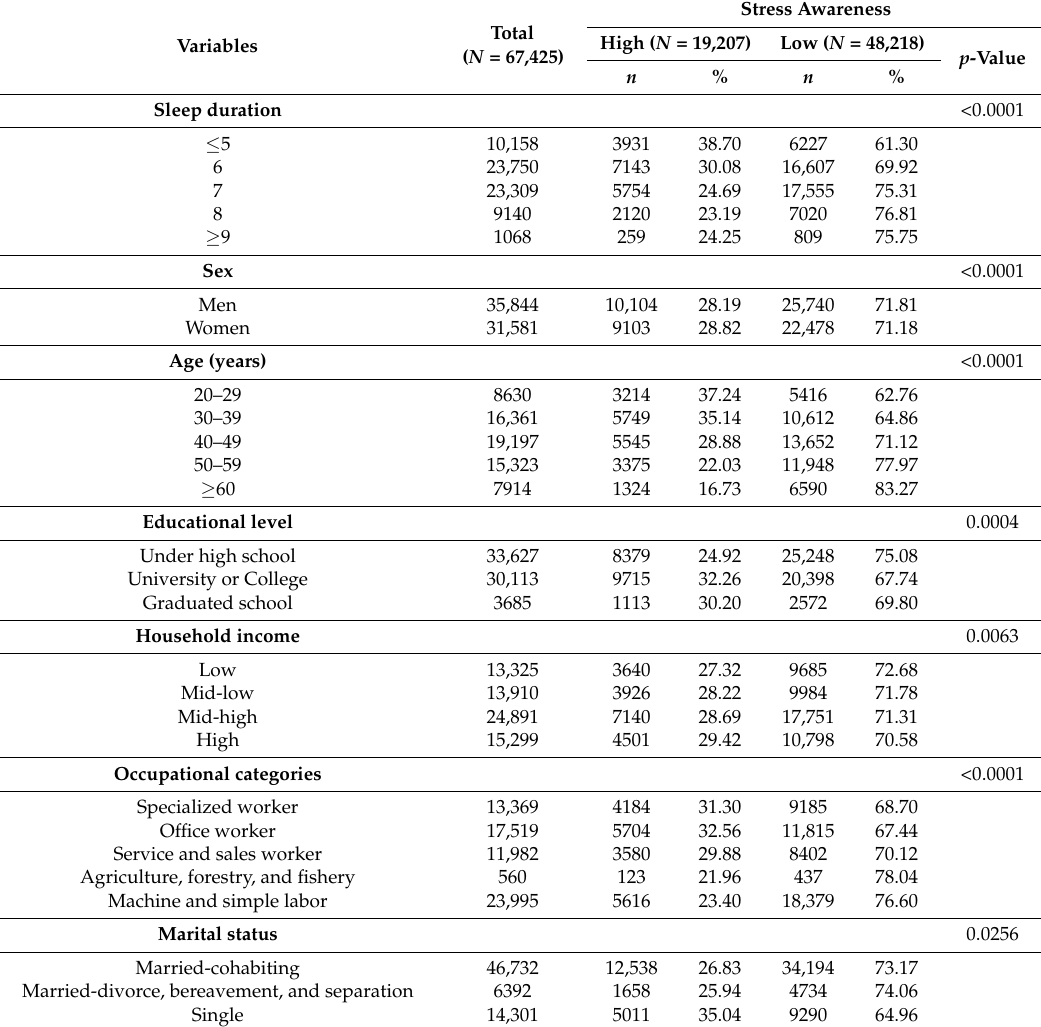
Table 1. The general characteristics of the study population in this study.